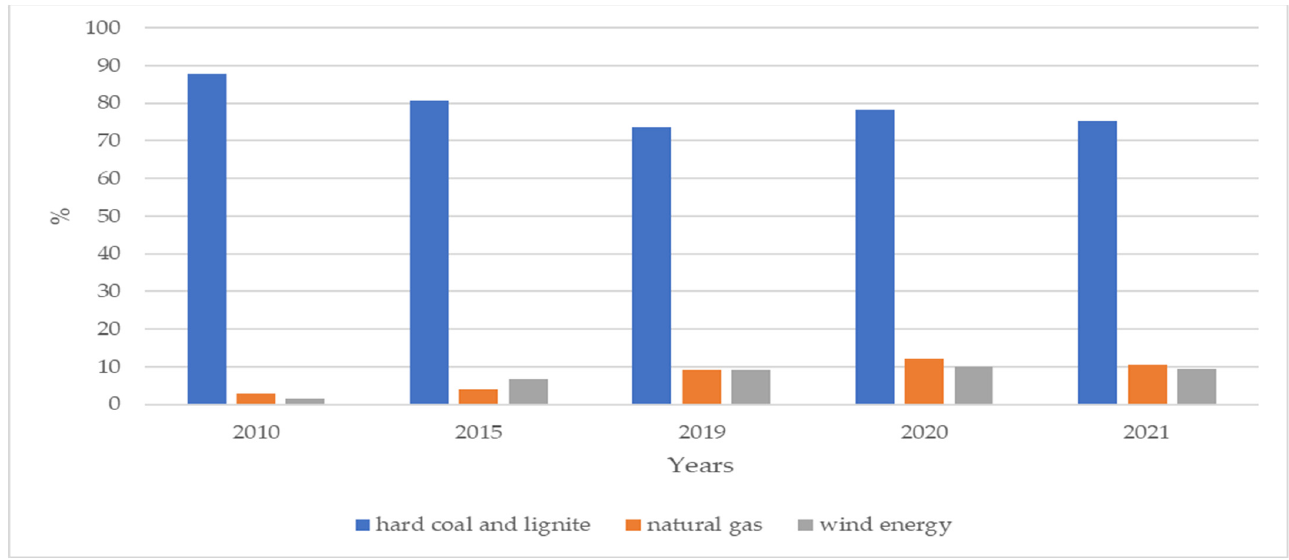
Figure 3. The structure of electricity production in Poland in 2010–2021 (%) . Source: own elaborations based on [44].